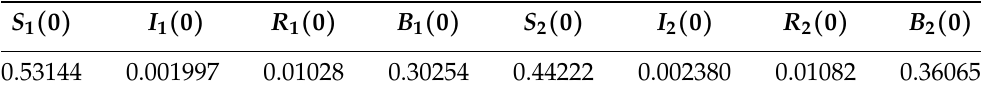
Table 3. Initial conditions for the fractional optimal control problem of Section 3.2 with parameters given by Table 1, corresponding to the endemic equilibrium of cholera model (3)–(4) with classical derivative